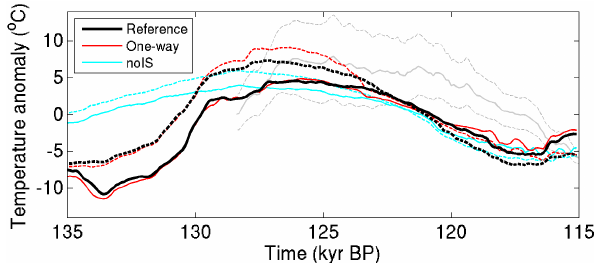
Figure 6. Comparison of modelled north-eastern Greenland annual mean (solid) and summer (June–July–August, dashed) surface tem- perature evolution (72–83 ◦ N and 306 ◦ 33 (cid:48) –317 ◦ 48 (cid:48) E) with recon- structed temperature changes (grey) at deep ice core site NEEM (77 ◦ 27 (cid:48) N, 308 ◦ 56 (cid:48) E). The solid grey line is the central estimate and grey dashed lines give the estimated error range for NEEM (NEEM community members,